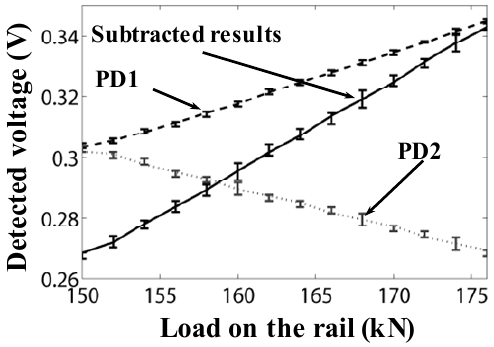
Figure 10. Static results with load from 150 to 176 kN.